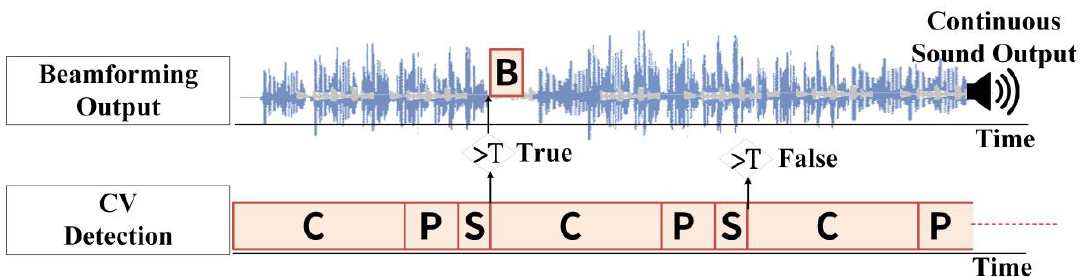
Figure 4. A parallel operation diagram of the asynchronous update function between CV and beamforming control.